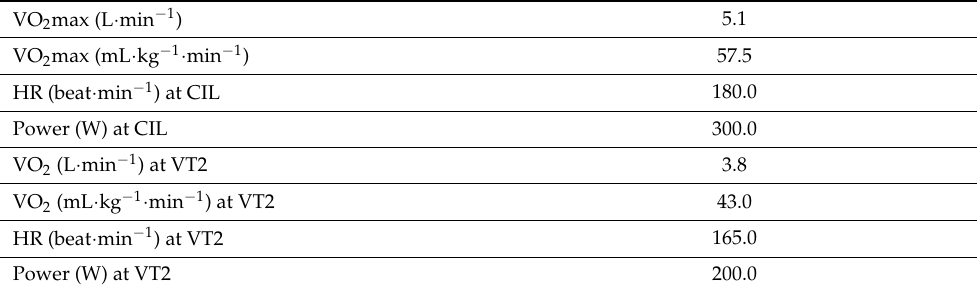
Table 1. Subject’s physical